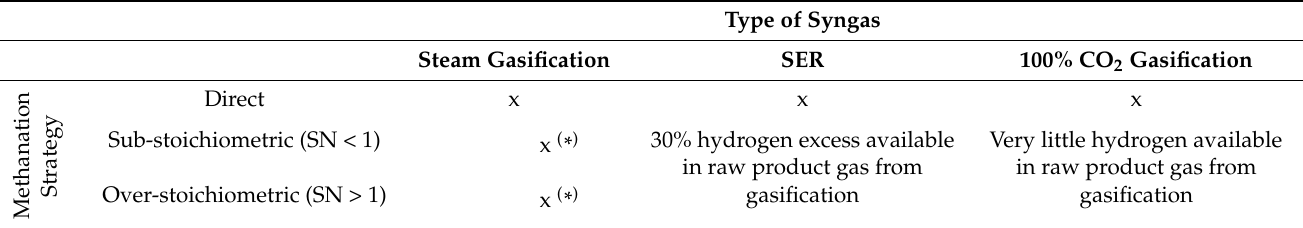
Table 2. Overview of applied methanation strategies on different syngas types with additional hydrogen supply from electrolysis